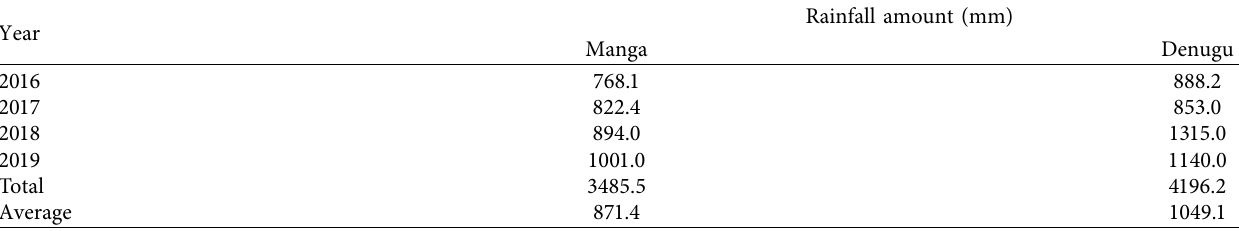
Table 2: Mean rainfall for Denugu and Manga sites from June to October for 2016 to 2019 cropping seasons.